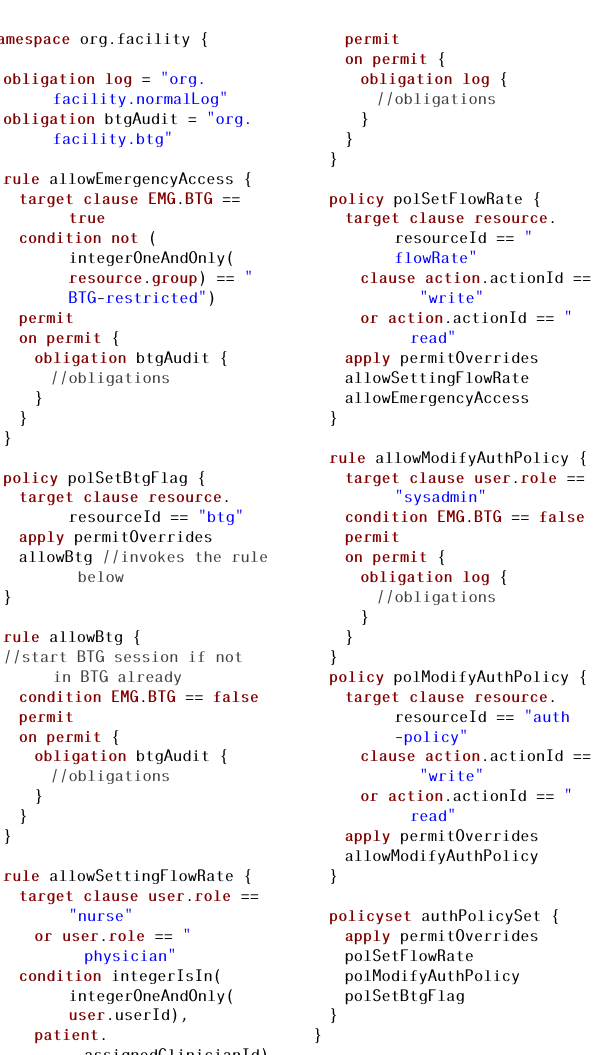
Figure 5. Example BTG policy written in ALFA, reformatted for